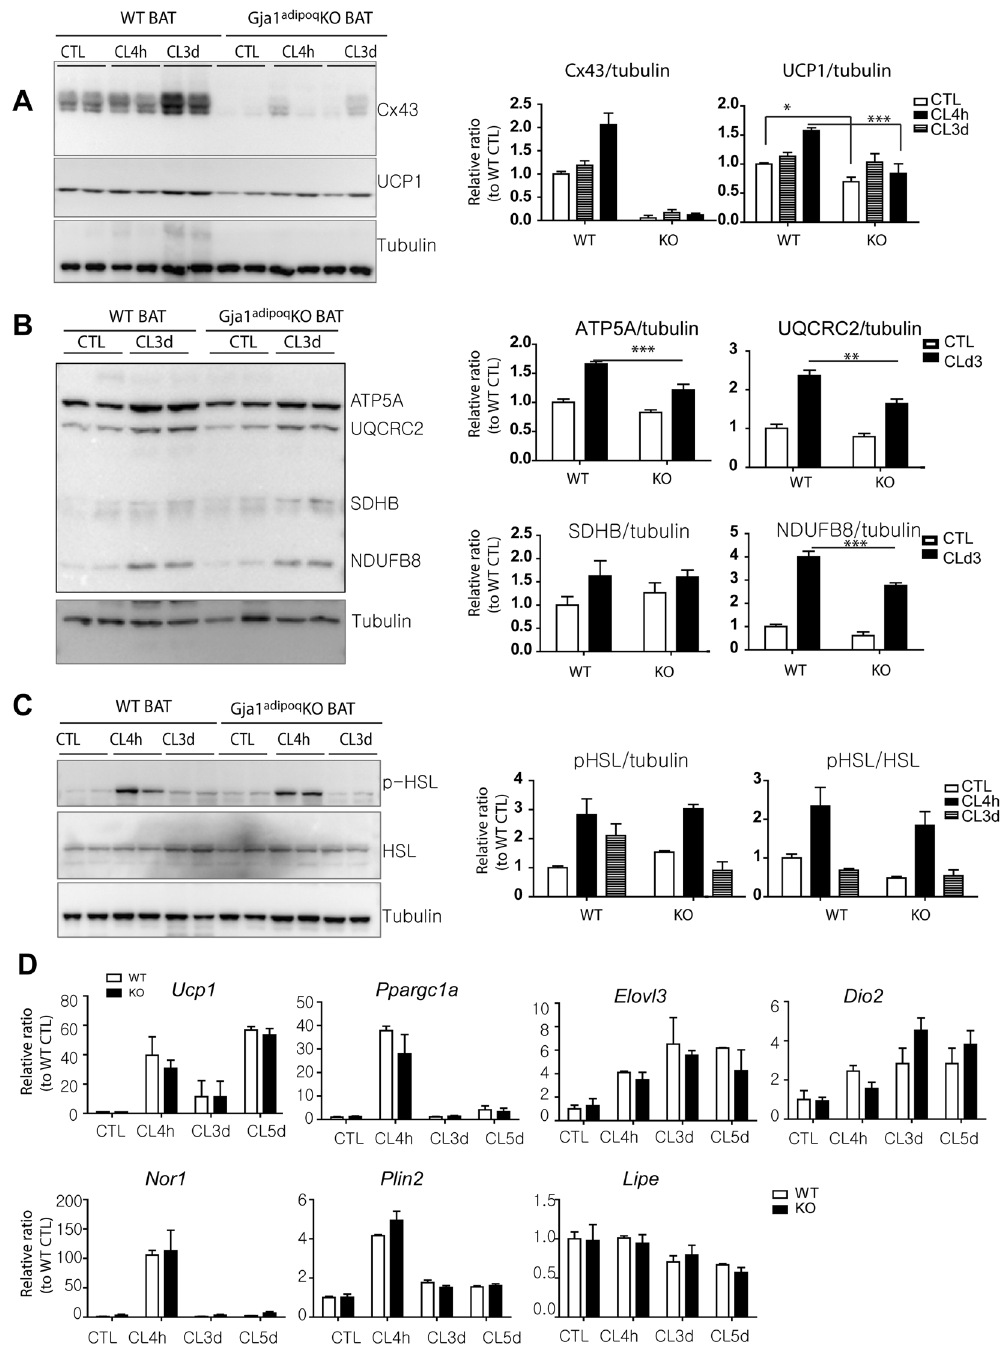
Figure 3. Adipocyte-specific Gja1 KO reduces mitochondrial contents, but not PKA-downstream signaling in BAT. ( A,B ). Immunoblot analysis of Cx43 and UCP1 expression ( A ) and mitochondrial proteins involved in oxidative phosphorylation ( B ) in BAT of Gja1 adipoq KO mice and WT controls treated with CL up to 3 days. Two- way ANOVA revealed significant main effects of Gja1 expression in mitochondrial proteins (UCP1: p = 0.0001, ATP5A: p = 0.0004, UQCRC2: p = 0.015, NDUFB8: p = 0. 0004) and significant interaction of genotype and treatment (UCP1: p = 0.0166, NDUFB8: p = 0.0264). Significant differences between WT and KO were determined by post-hoc pairwise comparison with Bonferroni correction (mean ± SEM; n = 4 per condition, * p < 0.01, ** p < 0.05, *** p < 0.001). ( C ) Immunoblot analysis of p-HSL and HSL expression in BAT of Gja1 adipoq KO mice and WT controls treated with CL up to 3 days (mean ± SEM; n = 4 per condition). ( D ) qPCR analysis of brown adipocyte markers and genes involved in downstream signaling of PKA activation in BAT of mice treated with CL for up to 5 days and untreated control mice. Two-way ANOVA revealed no significant main effects of Gja1 expression in mRNA levels ( Ucp1 : p = 0.4829, Ppargc1a : p = 0.178, Elovl3 : p = 0.261, Dio2 : p = 0.291, Nor1 : p = 0.583, Plin2 : p = 0.278, Lipe : p = 0.830) (mean ± SEM; n = 4 per condition). (Oil Vehicle controls in Fig. S2, Immunoblots accompanied by size markers in Fig.